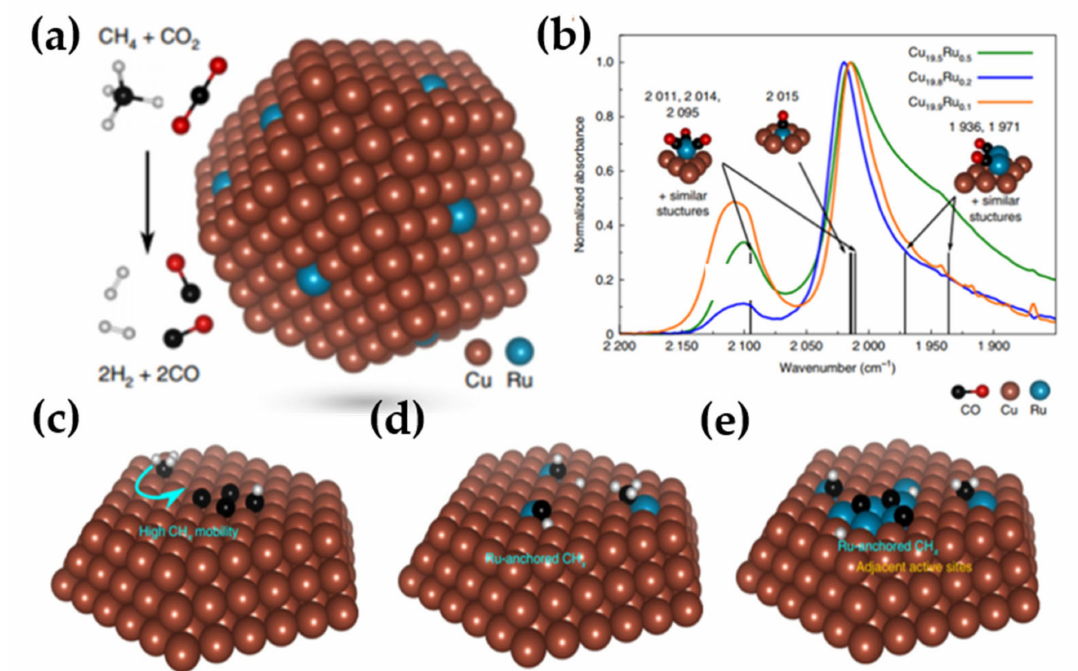
Figure 6. ( a ) Schematic of a Cu–single-atom Ru surface alloy catalyst with the dry reforming reactants and products shown on the left; ( b ) Infrared spectra of CO adsorbed on Cu–Ru catalyst surface at room temperature, and saturation coverage after a pretreatment at 200 ◦ C in 10% CO in Ar (100mlmin − 1 ) for 1h. Vertical lines located at the theoretical vibrational frequency of each structure are also shown. The relatively stronger peak at ~2100cm − 1 of Cu 19.9 Ru 0.1 probably results from variations in Ru distributions during catalyst treatment; ( c – e ) Schematics of the compositional dependence of the Cu x Ru y photocatalyst with respect to coke resistance: pure Cu ( c ), low Ru loading ( d ) and high Ru loading ( e )